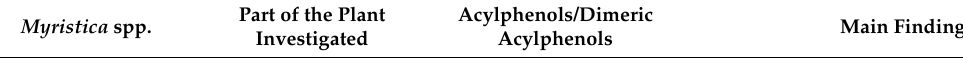
Compound 1 caused a minimal increase in the phosphorylation of PTEN, and a substantial time-dependent dephosphorylation of AKT and mTOR. Compound- 1 -induced generation of ROS was mediated via activation of the MAPK (p38 and JNK) pathway, along with inhibition of the PI3K/AKT pathway.